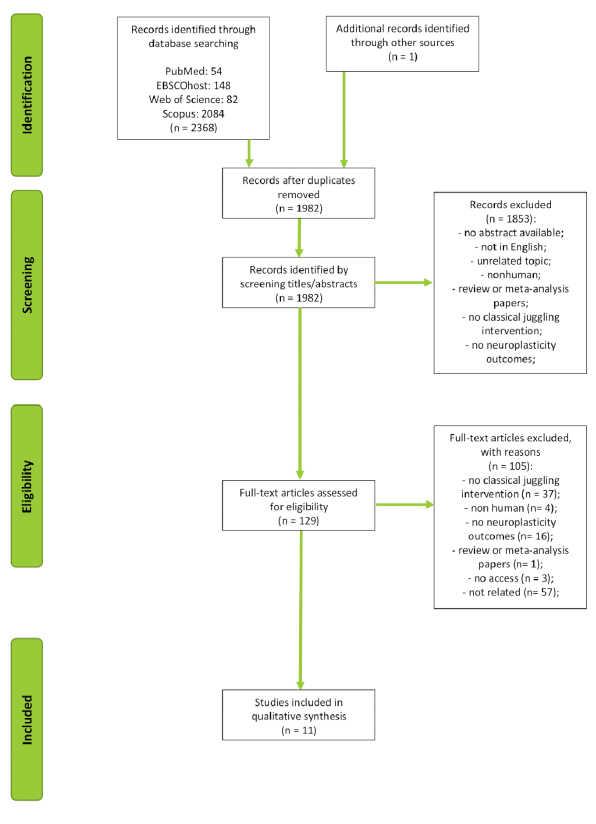
Figure 3. Study selection